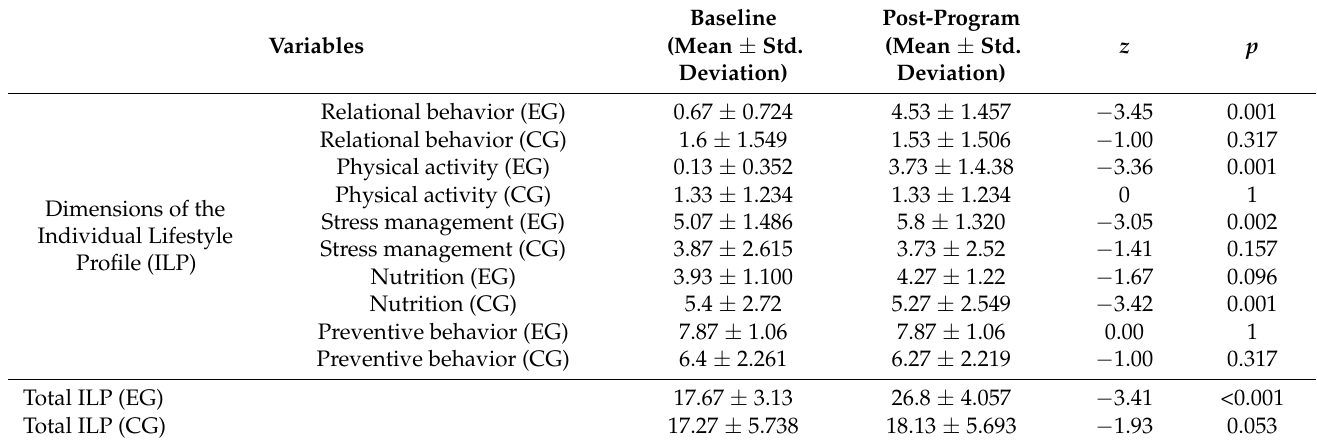
Table 5. Evaluations obtained at baseline and post-program in the ILP dimensions and ILP total di-